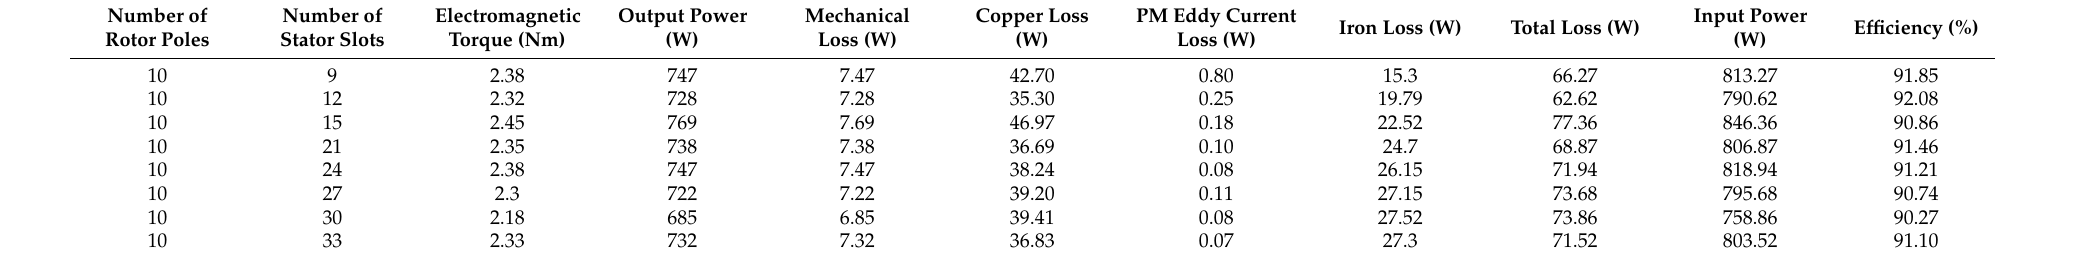
Table 10. Various losses and efficiency when the number of rotor poles is 10 and the number of stator slots takes different values. Number of Rotor